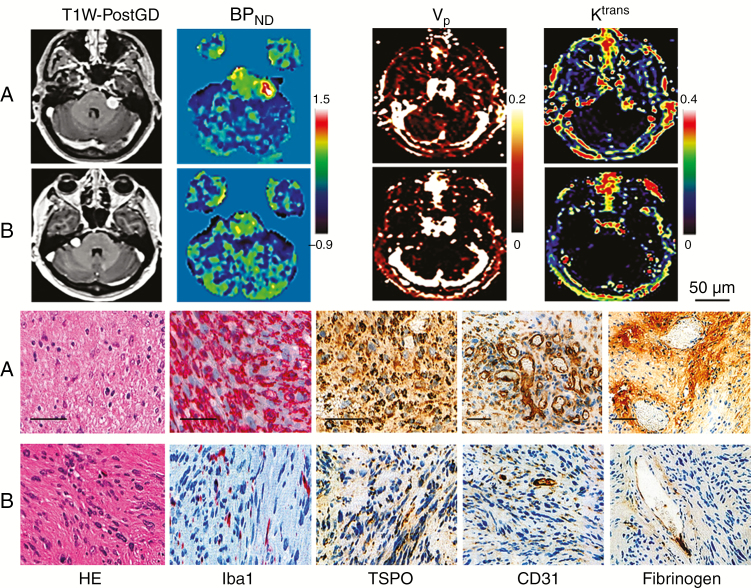
Representative images and histology from a 32-year-old male patient (patient 2) with a left sided growing sporadic VS (A); and a 61-year-old female (patient 9) with a static right-sided lesion (B).